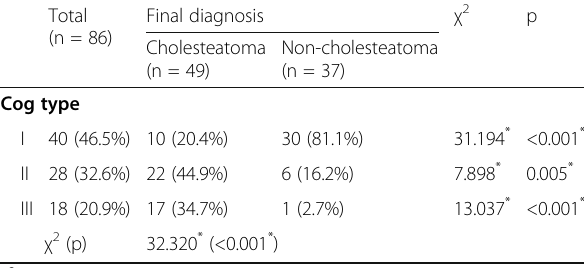
Table 2 Comparison between the cholesteatoma and non- cholesteatoma according to Cog type (I, II and III)